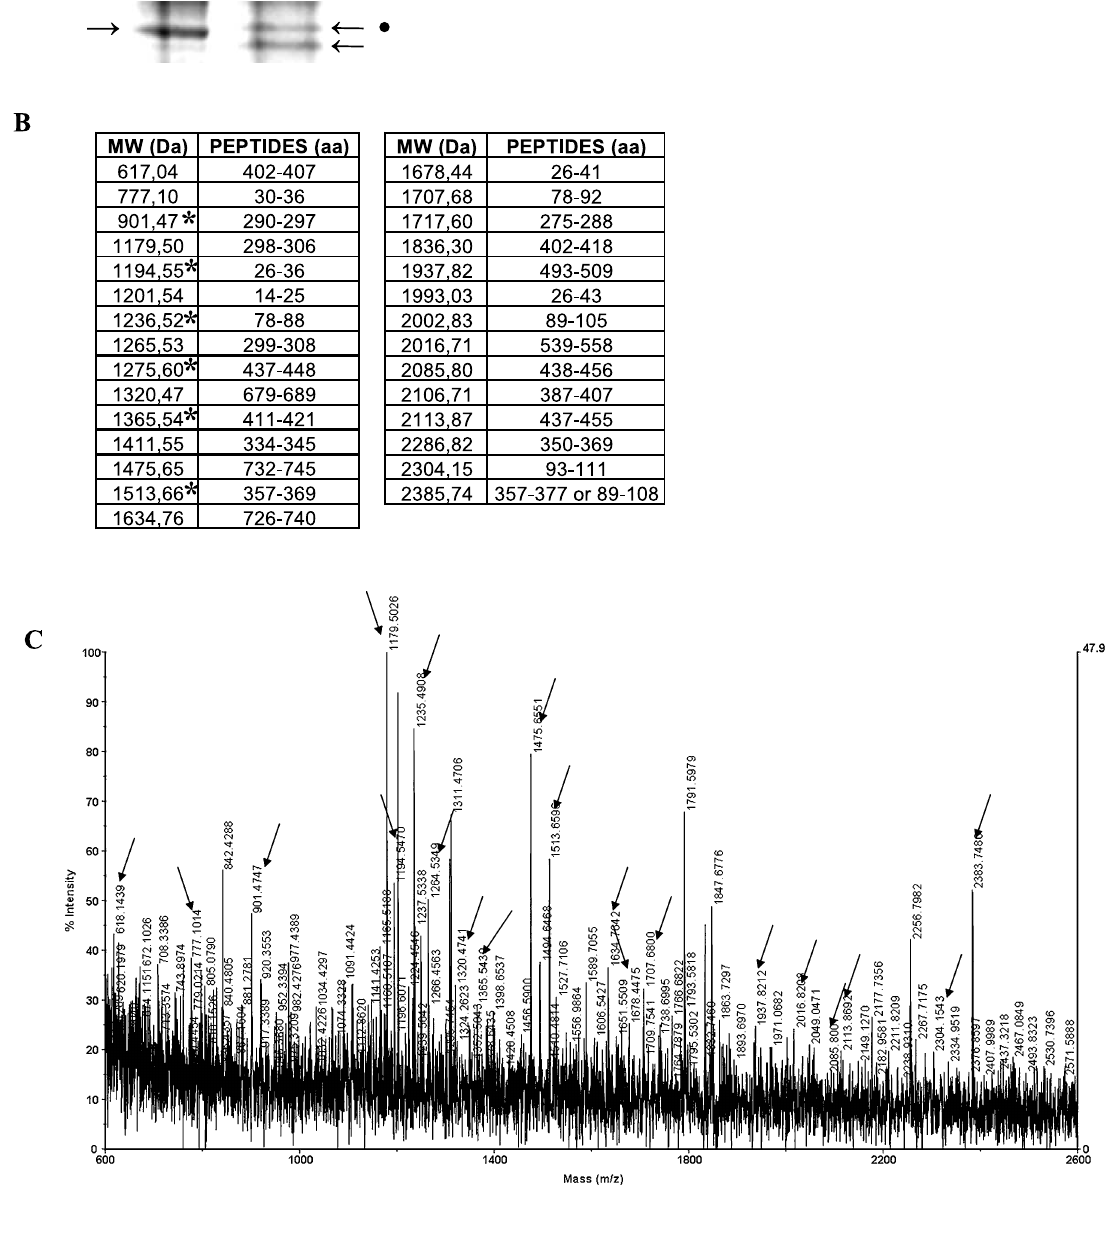
Fig. 2. (A) Coomassie-stained gel of MI-60 whole cell lysate (WCL) and MI-60 lysate immunoprecipitated with anti-MARK4L antibody (IP). The bands migrating around 90 kDa (arrowed) were excised and processed by mass spectrometry. (B) Set of 29 mass signals found within the MARK4L IP protein band ( • in Fig. 2A) assigned to the corresponding peptides within the MARK4L sequence. The asterisks indicate the mass values matching those within the MARK4L WCL band. (C) MALDI-mass spectrum (ranging from 600 to 2600 Dalton) of the digested peptides from the 90 kDa IP band ( • in Fig. 2A). Of the 29 signals assigned to MARK4L, only 20 (arrowed) are visible because of the compactness of the mass spectrum; the other nine are visible in zoomed portions of the spectrum (not